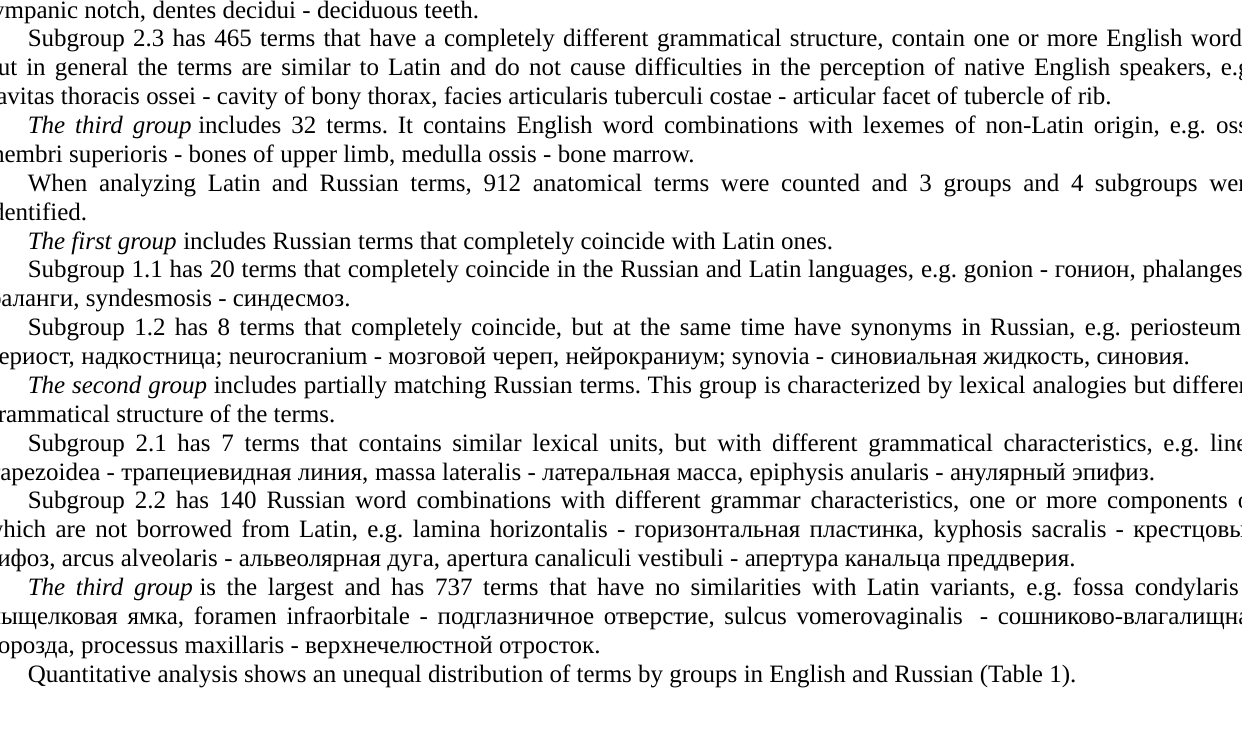
Table 1 - Quantitative distribution of anatomical